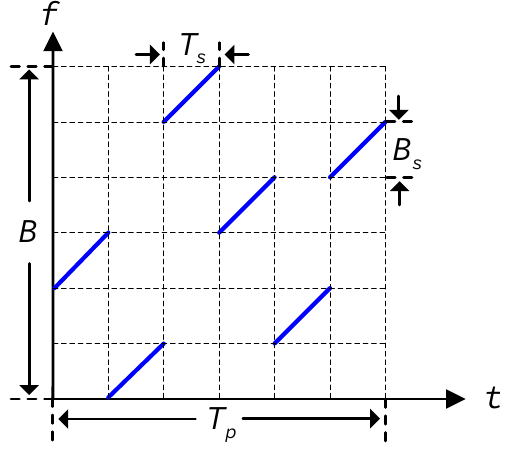
Figure 2. Intra-pulse frequency agile waveform time–frequency